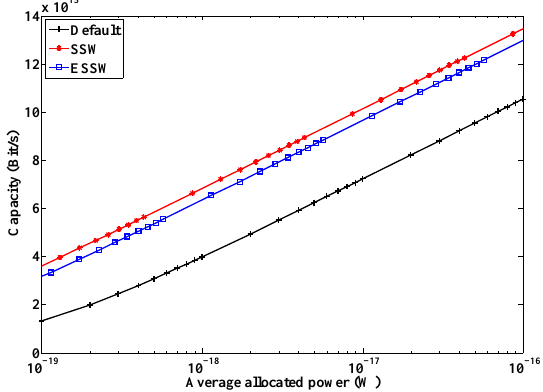
Figure 7: Capacity of different protocols as a function of average allocated power in alveolus